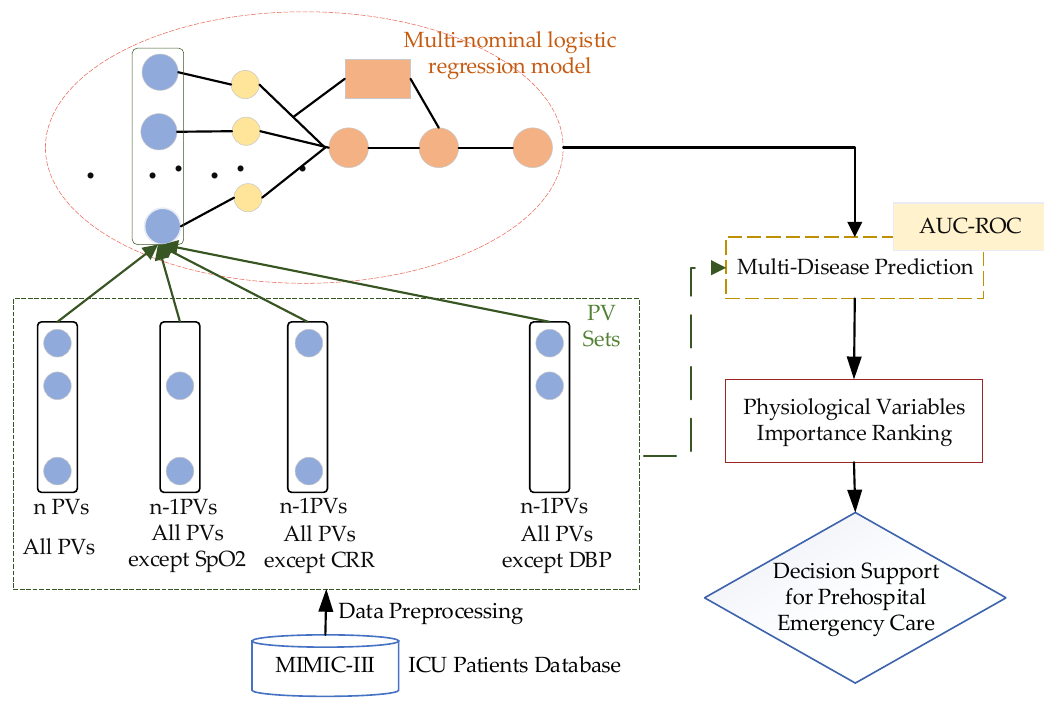
Figure 1. A decision support method for prehospital emergency care based on ranking the importance of physiological variables (PVs). AUC-ROC, area under the receiver operator characteristic curve; ICU, intensive care unit; MIMIC-III, Medical Information Mart for Intensive Care; SpO2, oxygen saturation; CRR, capillary refill rate; DPB, diastolic blood pressure.